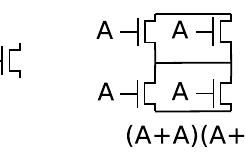
Figure 3. Quadded Redundancy: ( A + A )( A + A )